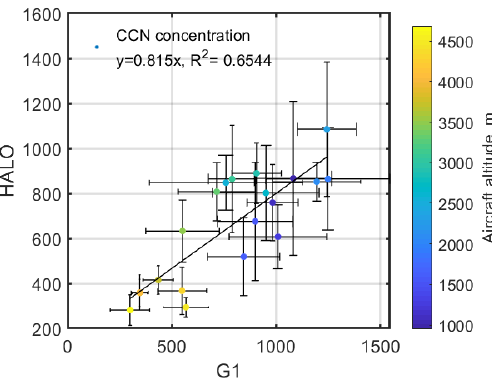
Figure 13. The G1 and HALO comparison of aerosol CCN concen- tration ( S = 0 . 5%) measured on 21